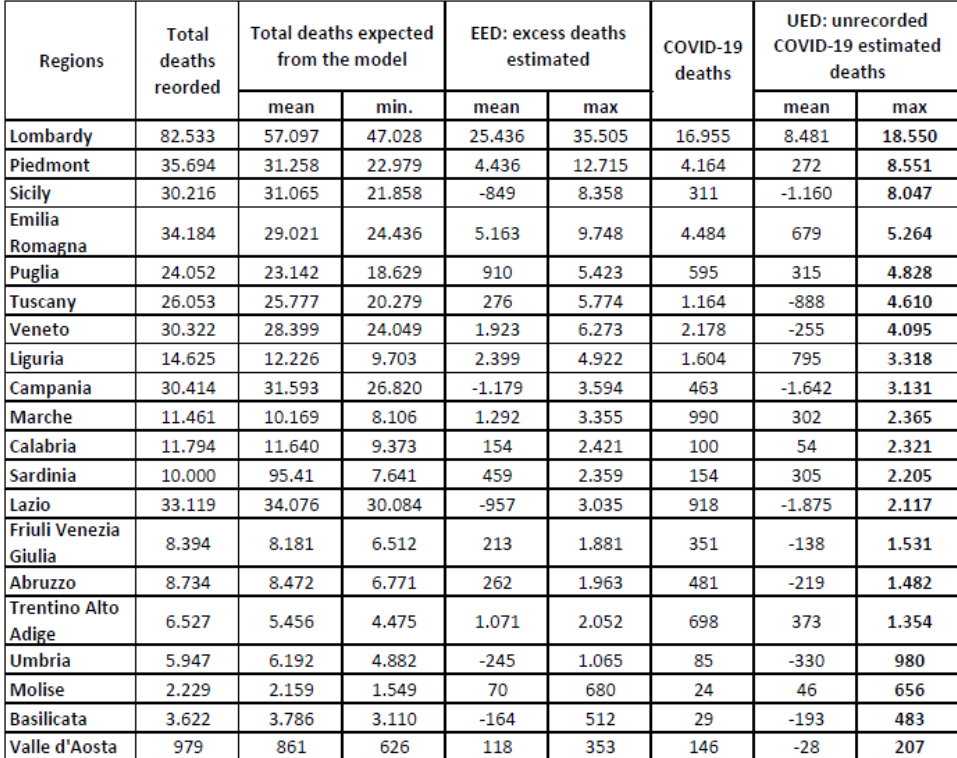
Table 6. Results obtained from the analysis of the deaths recorded in each Italian’s regions (reference period